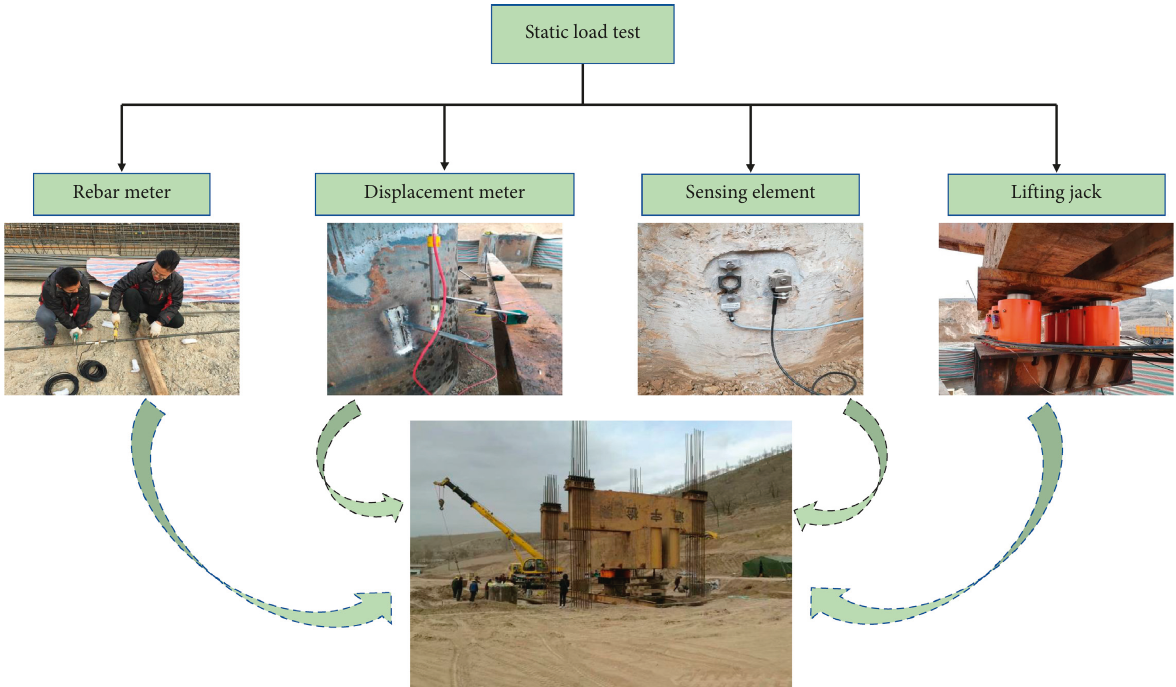
Figure 4: Static load test.